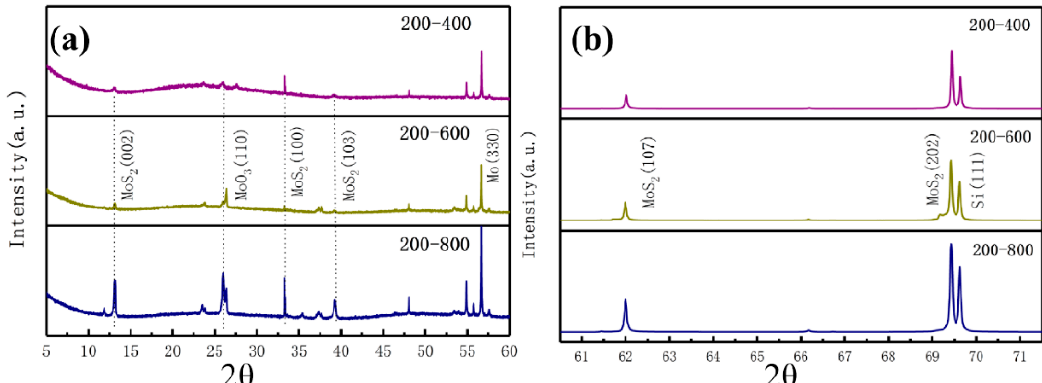
Figure 5. XRD spectrum of the MoS 2 films prepared at 200 °C after annealing at 400 °C, 600 °C, and 800 °C. Different diffraction angle range: ( a ) 2 θ = 5°~60°, ( b ) 2 θ = 60.5°~71.5°. (Picture a and b are continuous, and picture a is magnified)